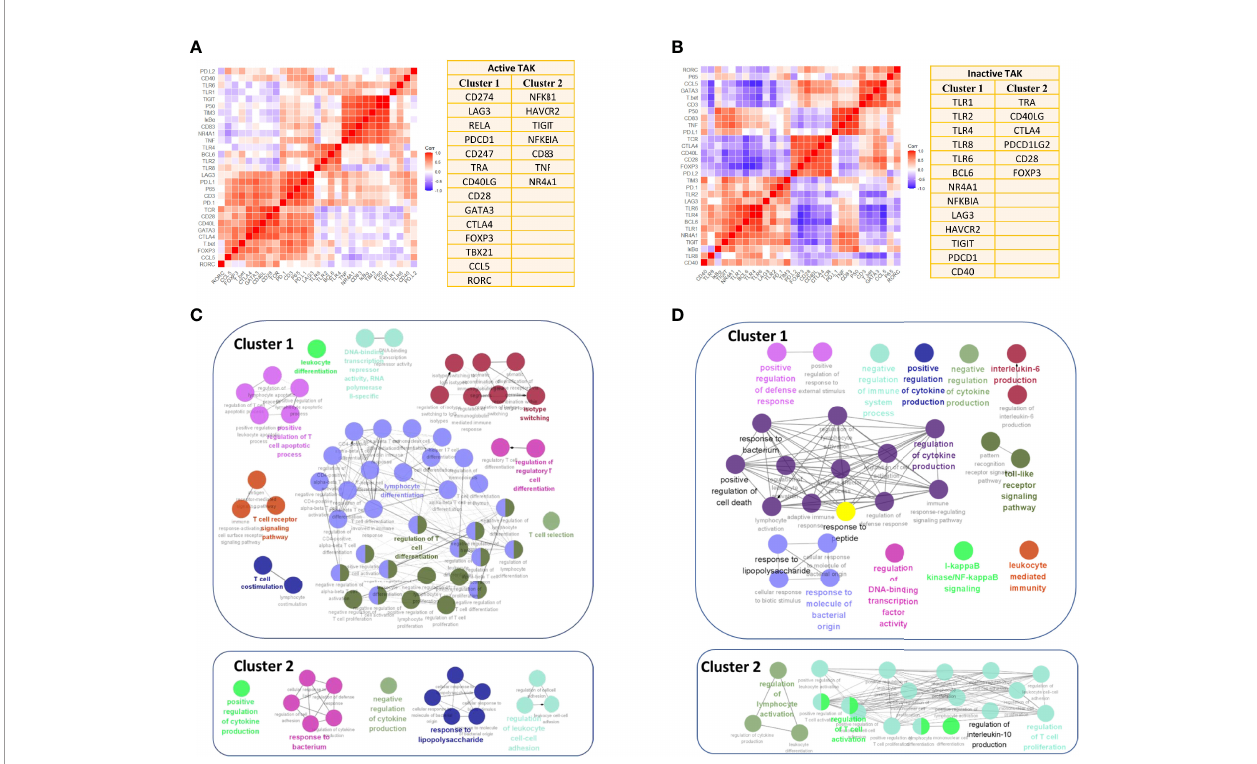
FIGURE 10 | Enrichment for activated signaling pathways of the inactive-treated and the active-treated TAK patients. (A, B) The two greatest gene clusters of the active-treated (A) and the inactive-treated TAK group (B) . (C, D) Functional enrichment analysis results of the active-treated (C) and the inactive-treated TAK group (D) , revealing the potentially activated signaling pathway at the active or the inactive stage of TAK. TAK, Takayasu ’ s